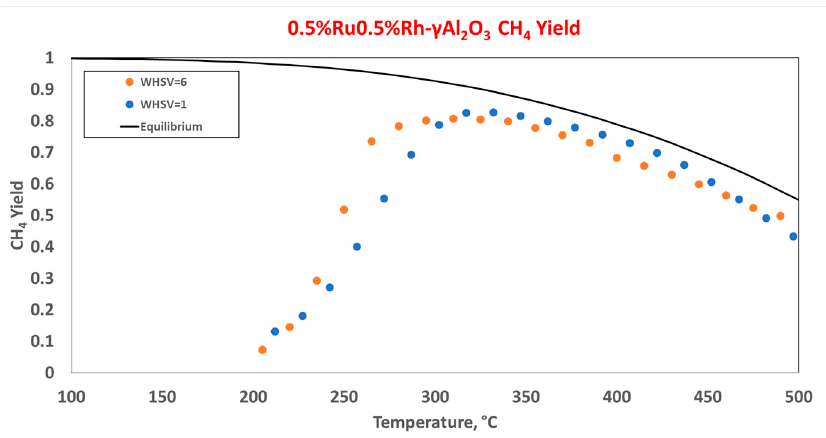
Figure 10. RuRh- γ Al 2 O 3 CH 4 selectivity comparison between the two space velocities.